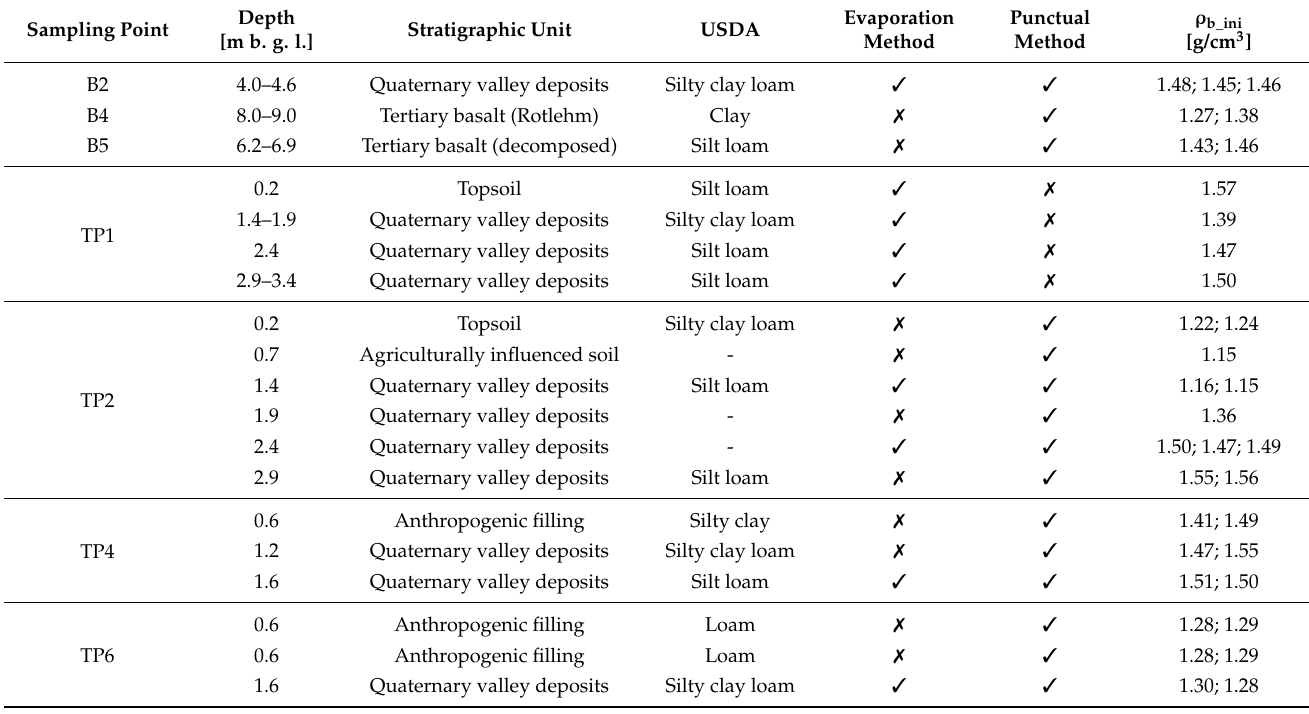
Table 3. Soil samples, with sampling depth in meters below ground level (m b. g. l.) and USDA (U.S. Department of Agriculture) soil classification, on which thermal conductivity measurements were performed. In addition, the bulk density ( ρ b_ini ) with which the soil sample was initially installed in the measuring cylinder is shown. By installing the sample twice with the punctual method, ρ b_ini can also differ slightly within the